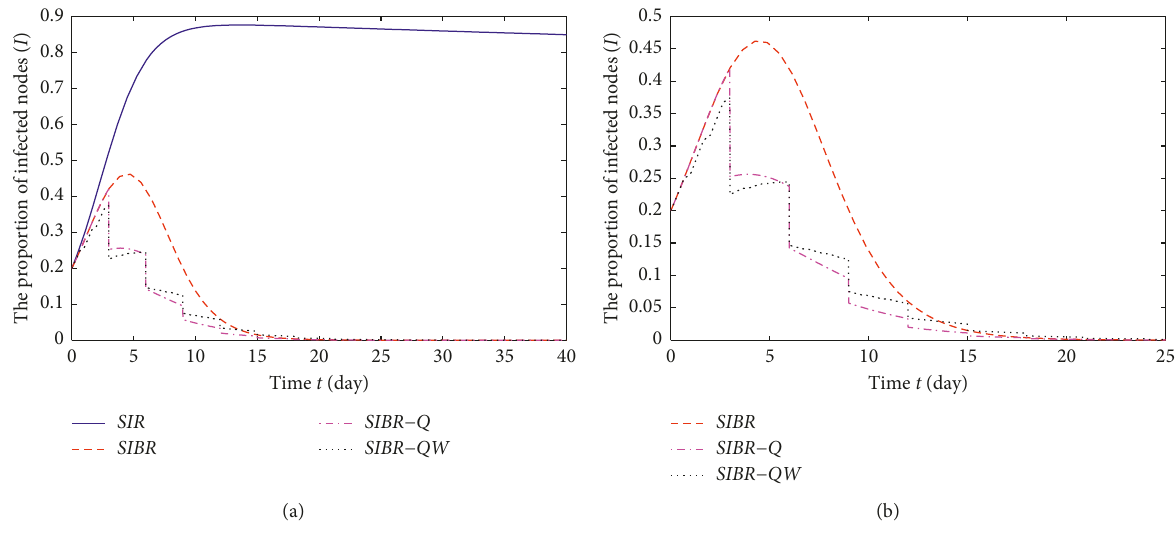
Figure 3: (a) Comparison between four models, in terms of the number of malicious worms. (b) Comparison between SIBR − Q and SIBR − QW